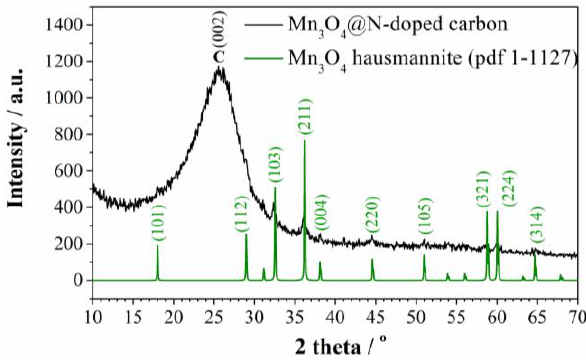
Figure 1. XRD diffractogram of Mn 3 O 4 @N-doped carbon.